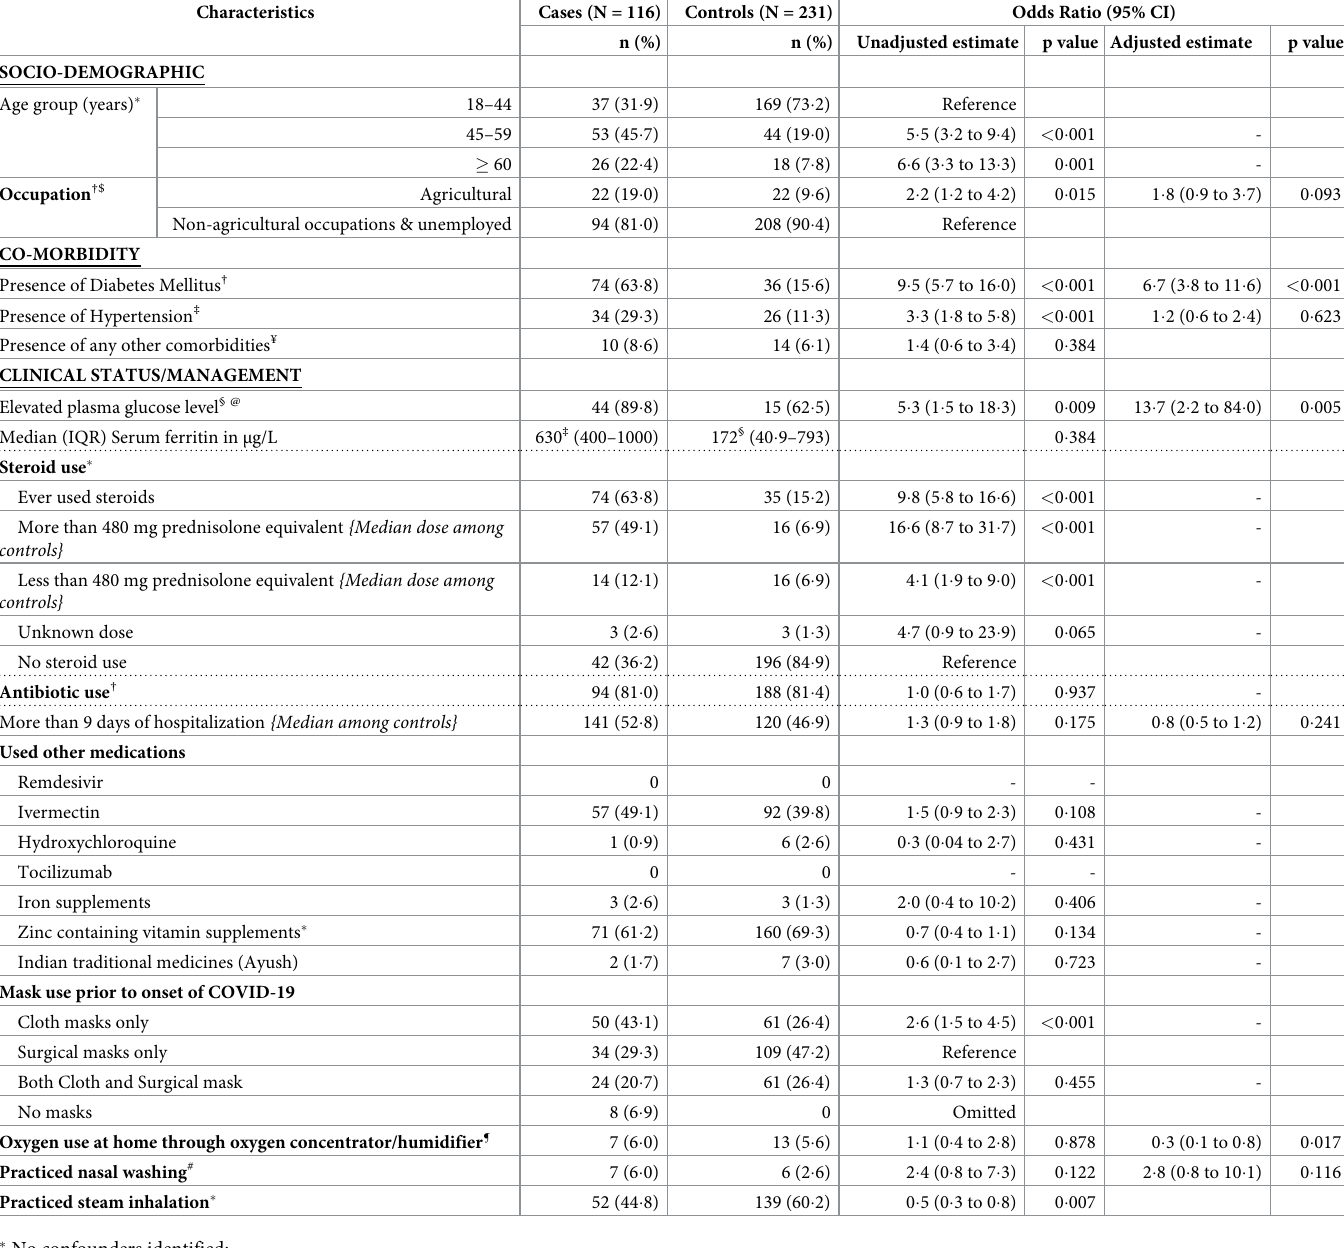
Table 3. Risk factors for mucormycosis among never-hospitalised COVID-19 patients, multi-centric case-control study of post-COVID rhino-orbito-cerebral mucormycosis, India, 2021.